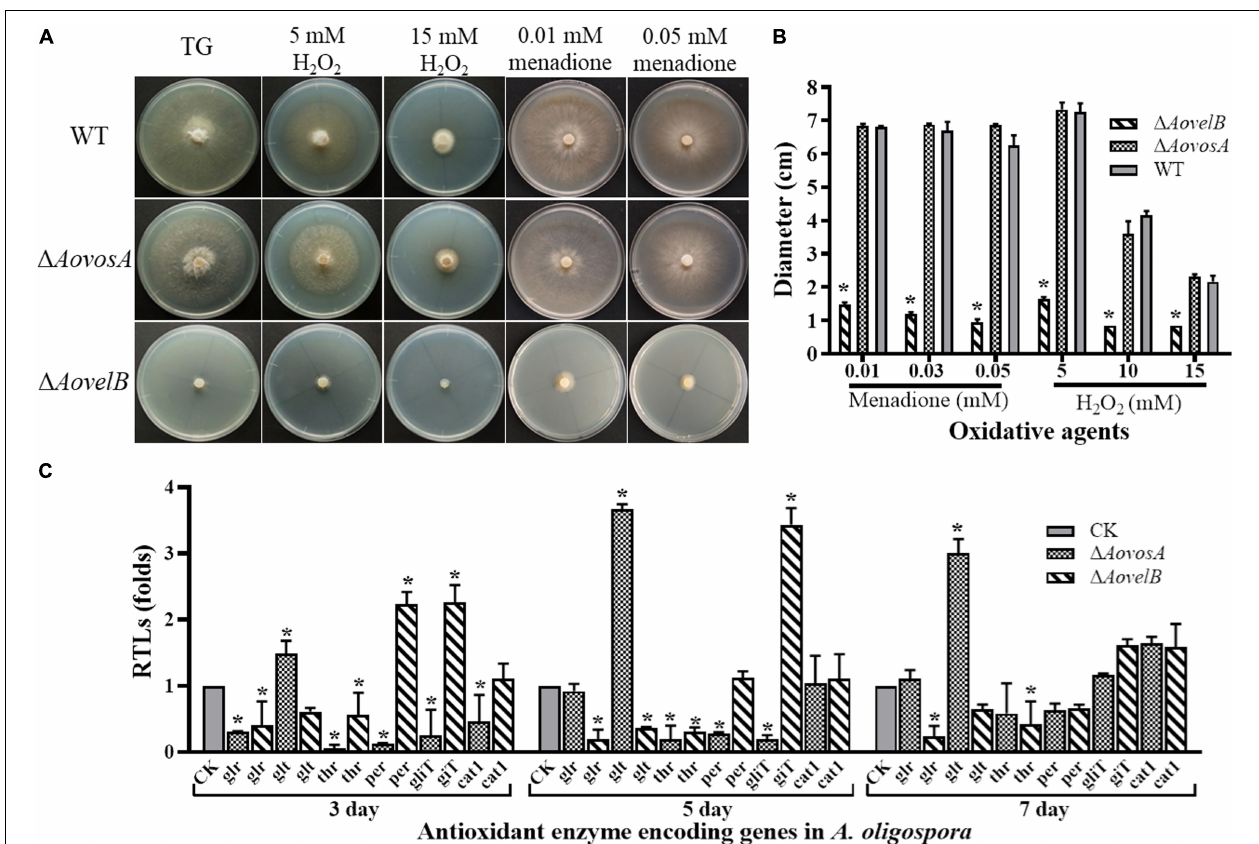
FIGURE 6 | Comparison of stress tolerance to oxidative agents. (A) Colony morphologies of the WT and mutant lines incubated on TG medium supplemented with H 2 O 2 or menadione. (B) . Colony diameters of the WT and mutants after incubation on TG medium supplemented with 5–15 mM H 2 O 2 or 0.01–0.05 mM menadione for 5 days. (C) Relative transcriptional levels (RTLs) of oxidation-related genes in the mutants compared with the WT strain at different time points. CK. The level of each gene was computed as a ratio of the transcript level of the gene in the deletion mutant to that in the WT strain under a given condition. An asterisk indicates a significant difference between the mutants and the WT strain ( p <